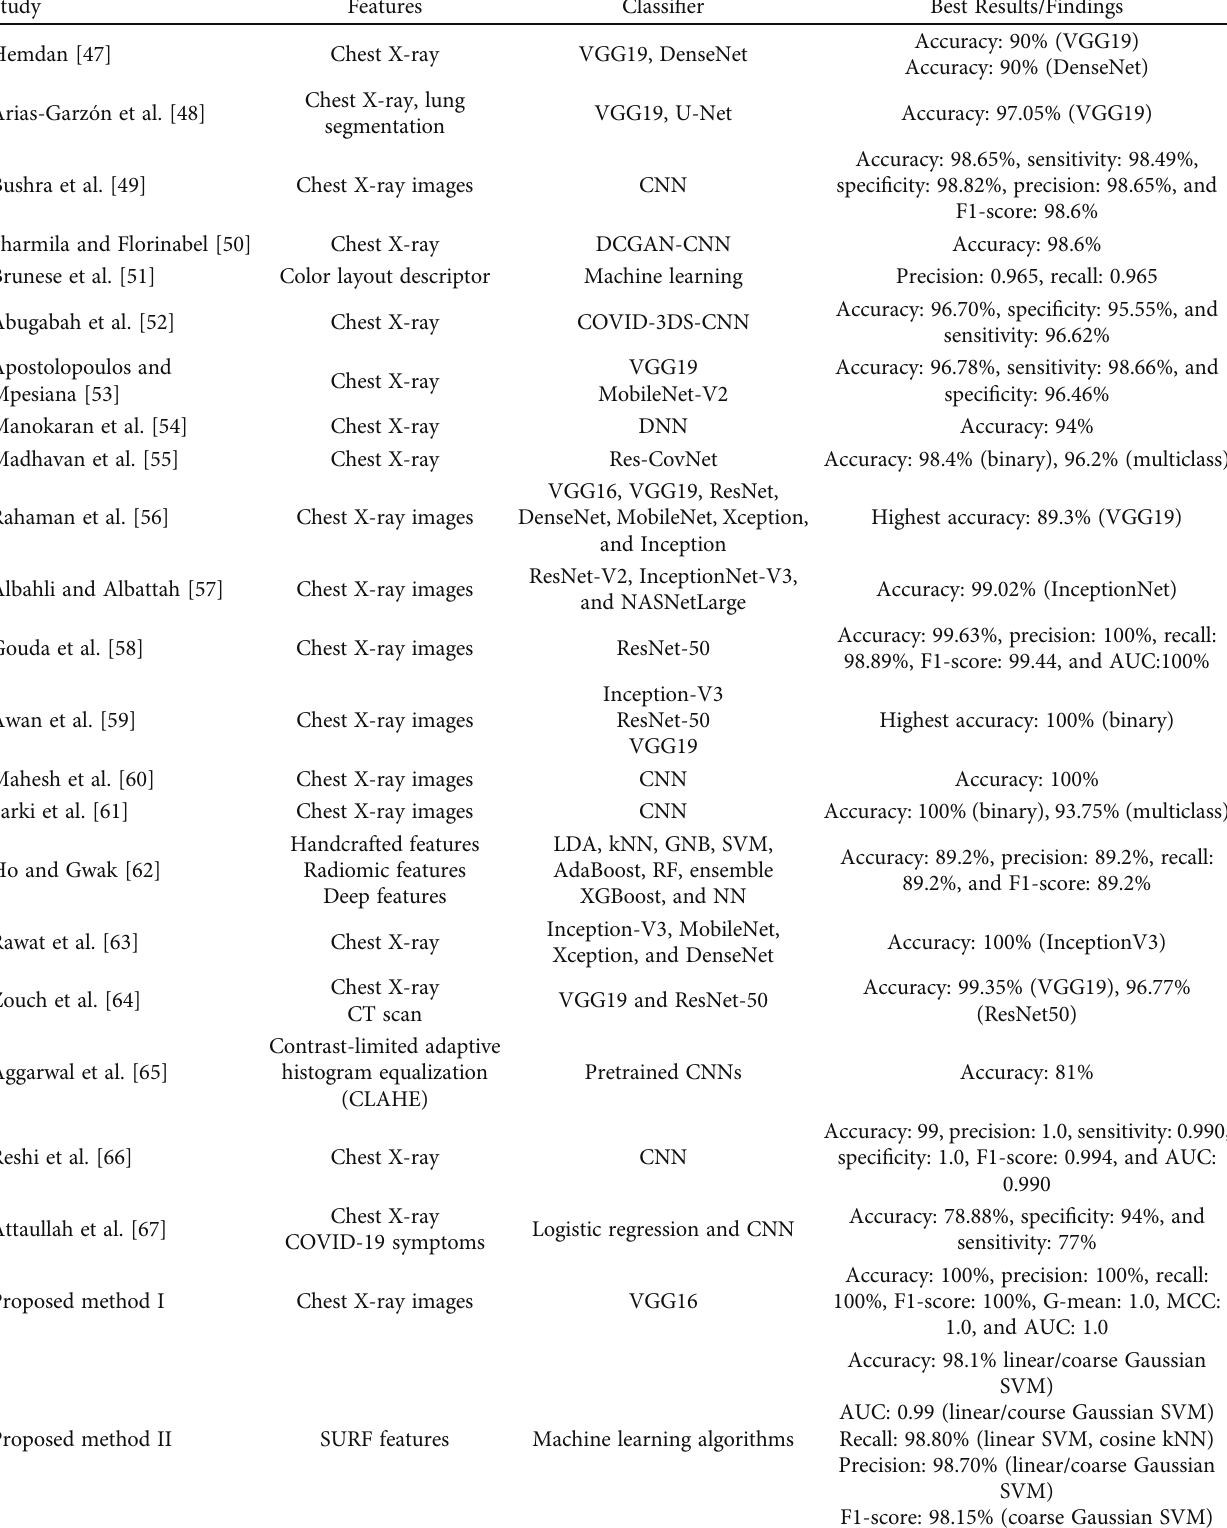
Table 7: The performance